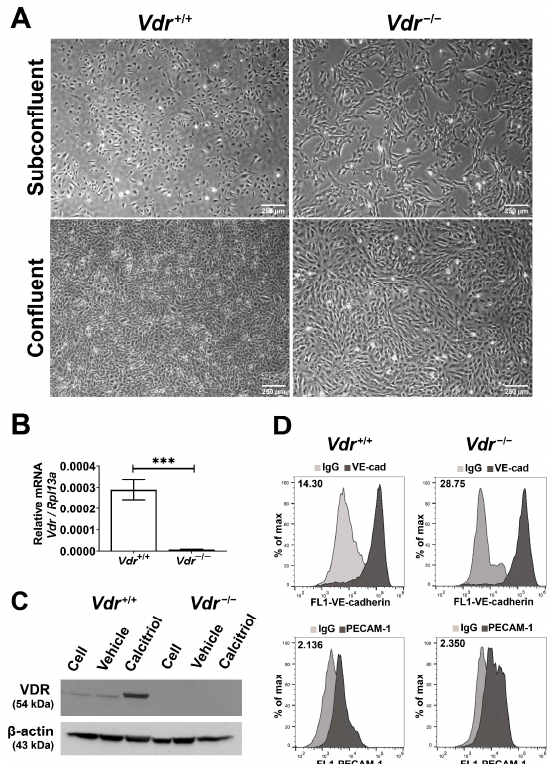
Figure 1. Isolation and characterization of mouse retinal EC. Vdr +/+ and Vdr − / − retinal EC were prepared and cultured as described in Materials and Methods. ( A ) Morphology of cells at subconfluent and confluent. ( B ) Vitamin D receptor expression levels were accessed by qPCR analysis (n = 3, *** p < 0.001). ( C ) Cells were incubated with medium alone (cells), 0.41% ethanol (vehicle), or 10 μ M calcitriol for 24 h and VDR levels were measured by Western blot analysis. ( D ) Expression levels of EC markers were determined by flow cytometry. VE-cad; VE-cadherin and PECAM-1; Platelet en- dothelial cell adhesion molecule-1. Relative median fluorescent intensities are indicated in the top left corner of each panel. These cells were also positive for B4-lectin (a mouse EC specific lectin) and lacked the expression of PDGFR β and smooth muscle actin (pericyte markers; not shown).